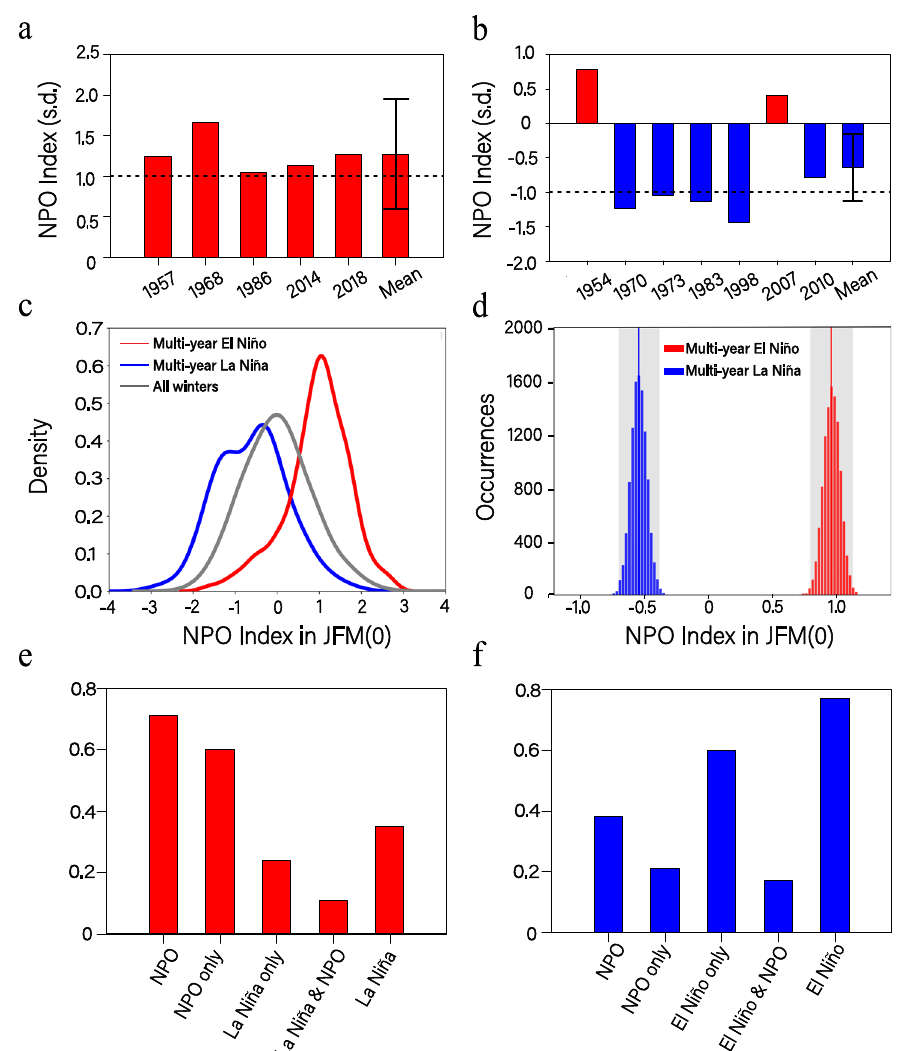
Fig. 1 The NPO states prior to multi-year El Niño and La Niña events in the observations and models. Normalized JFM(0) NPO indices for a the fi ve selected multi-year El Niño events and b the seven selected multi-year La Niña events in observations. Error bars in the ensemble mean indicate the 95% con fi dence interval, and horizontal dashed lines represent one positive and one negative standard deviation in a , b , respectively. c Probability density functions (PDFs) of the normalized JFM(0) NPO indices for multi-year El Niño events (red curve), multi-year La Niña events (blue curve), and all winters (gray curve) in the CMIP5/6 models. d Histograms of 10,000 realizations of the bootstrap method for the normalized JFM(0) NPO indices of multi-year El Niño (red) and La Niña (blue) events in the CMIP5/6 models. Vertical red and blue lines indicate the mean values of 10,000 inter-realizations for the boreal winter NPO index before multi-year El Niño events and multi-year La Niña events, respectively. Gray shaded regions indicate the respective doubled standard deviations (SDs; the 95% con fi dence interval based on the normal distribution) of the 10,000 inter-realizations (see Methods). e Ratios of multi- year El Niño events preceded by NPO events (NPO), NPO without La Niña events (NPO only), La Niña occurring without NPO events (La Niña only), La Niña with NPO events (La Niña & NPO), and La Niña events (La Niña) during JFM(0) in the CMIP5/6 models. f As in e , but for the ratios of multi-year La Niña events preceded by NPO, NPO only, El Niño only, El Niño & NPO, and El Niño,